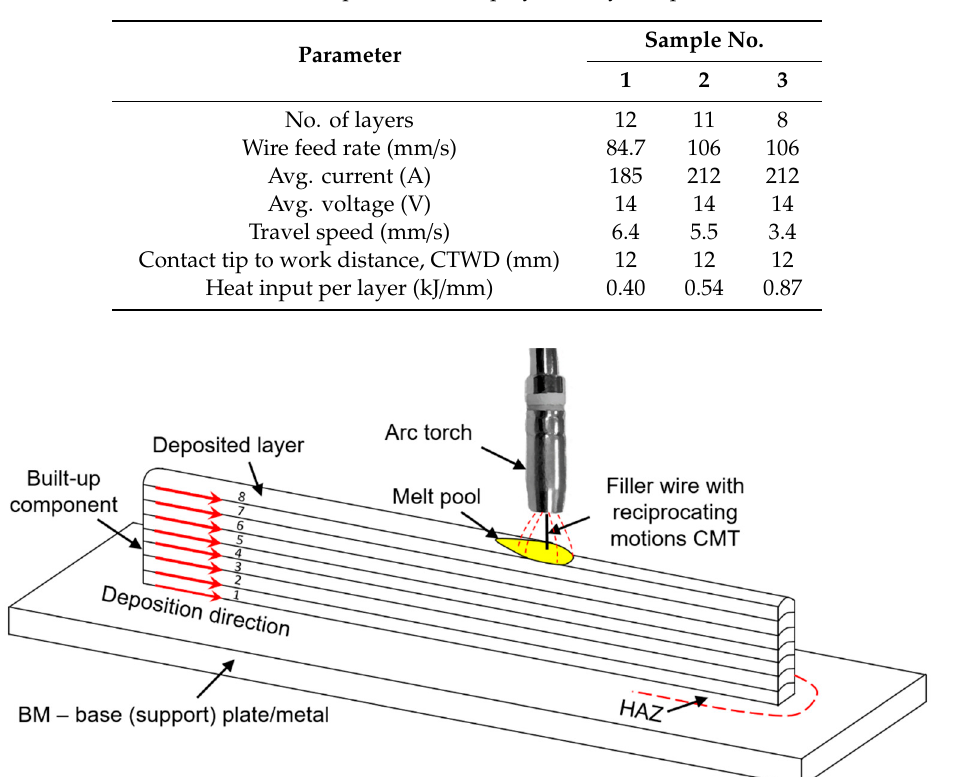
Figure 1. Schematic illustration of additive manufacturing of component.